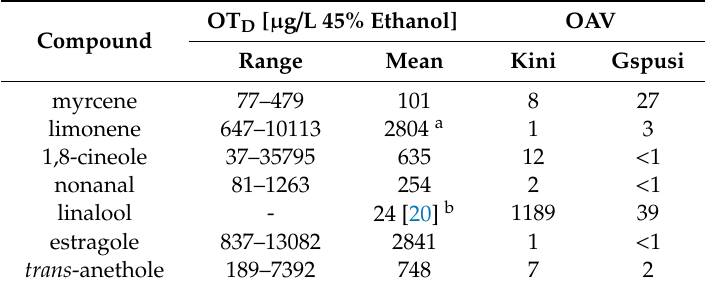
Table 3. Odor detection thresholds (OT D ) of seven selected aroma compounds as determined experimentally in 45%vol. ethanolic solutions, as well as the associated odor activity values (OAVs) calculated based on the concentrations of the individual compounds in the gins.